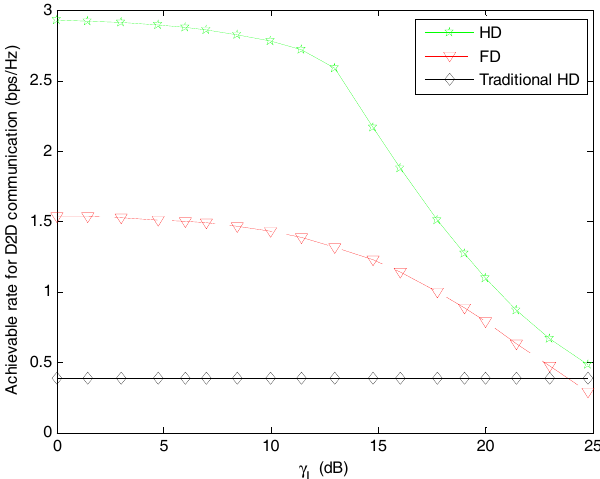
Figure 4. The performance of the D2D transmission rate with different loopback channel gains.